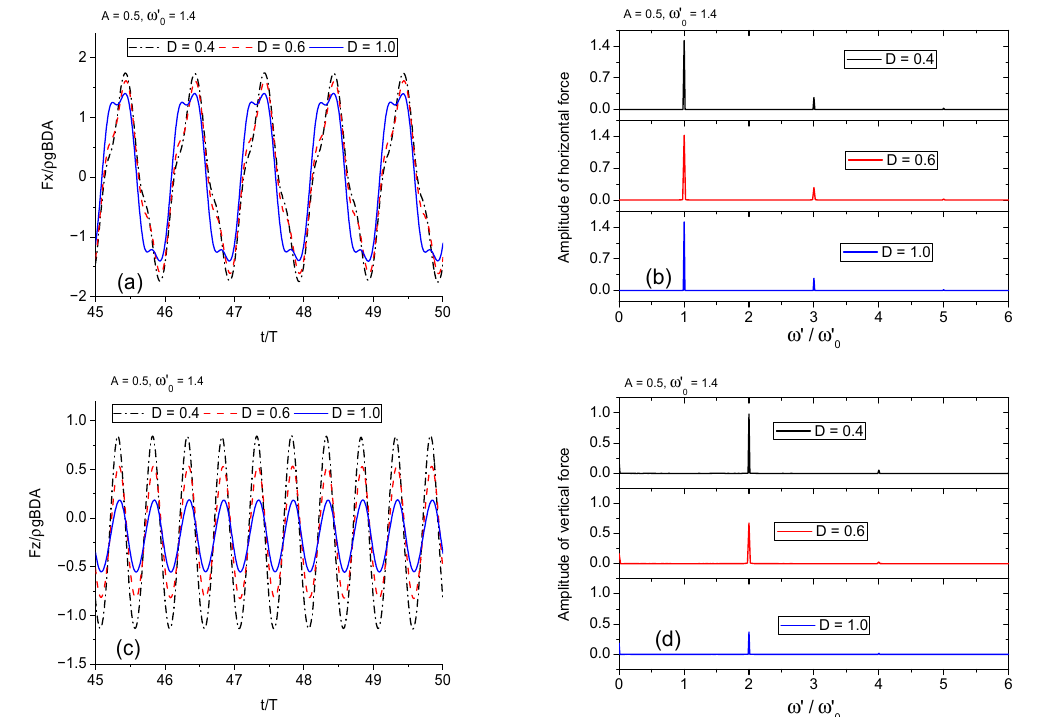
Figure 12. Normalized force histories of di ff erent draughts and their FFT analysis when A = 0.5, ω (cid:48) = 1.4: ( a ) horizontal force histories; ( b ) FFT analysis of horizontal forces; ( c ) vertical force histories; ( d ) FFT analysis of vertical forces.